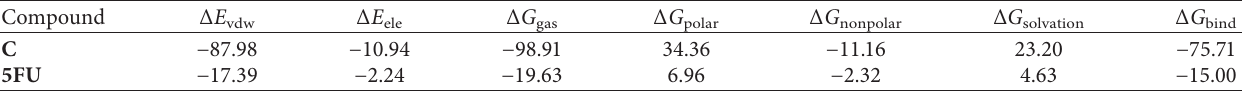
Figure 5: RMSD of compounds C -3 α -HSD (black) and 5FU-3 α - HSD (red) complexes during the 100ns MD simulations. Table 4: Calculated binding free energies and its components for the complexes using the MM-GBSA method extracted from the last 1000 frames of 100